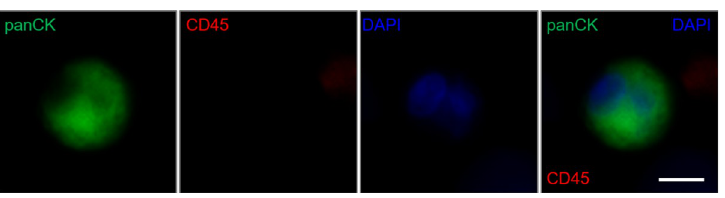
Fig 6. Immunocytochemistry images to evaluate a CTC from whole blood of an advanced breast cancer patient. A captured CTC on the microslit was immunostained with pan-cytokeratin (panCK, green), CD45 (red) and DAPI (blue). CTCs were detected with panCK (+), CD45 (-) and DAPI (+) and a representative sample was shown (Scale bar, 10 μ